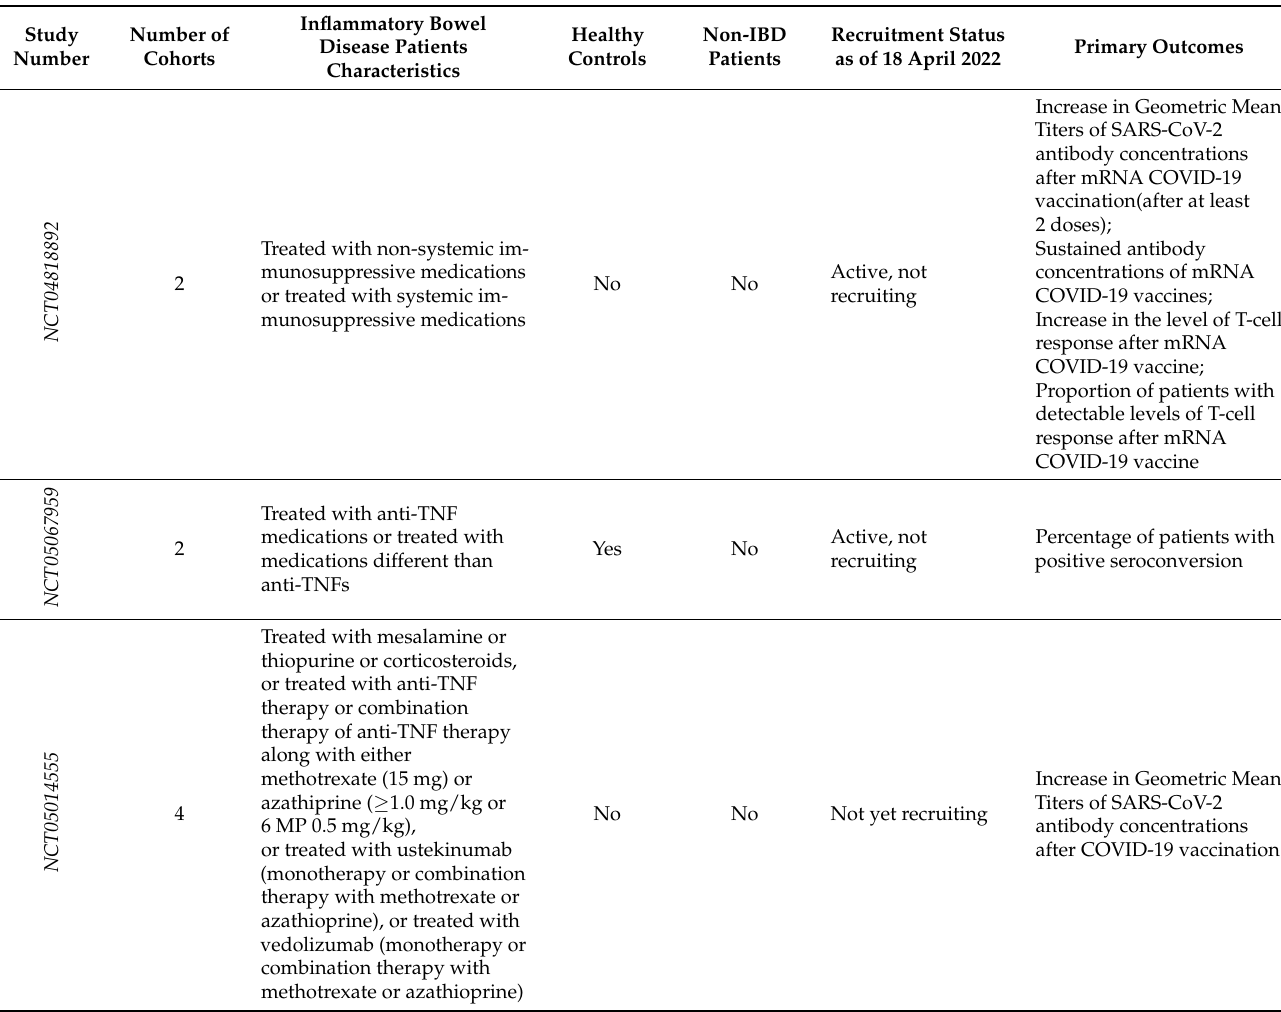
Table 2. Currently ongoing COVID-19 vaccination trials according to clinicaltrials.gov (accessed on 18 April